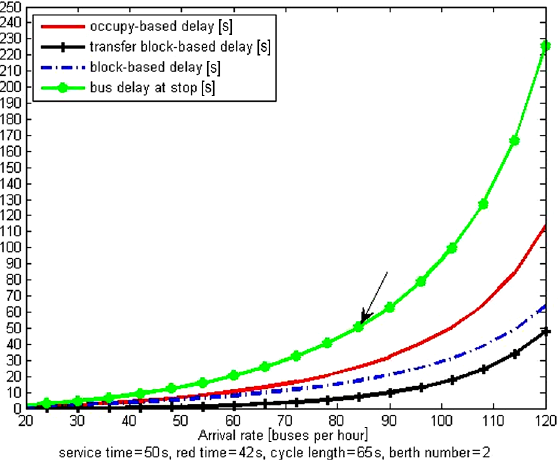
Fig. 6. The impact of arrival rate on bus delay